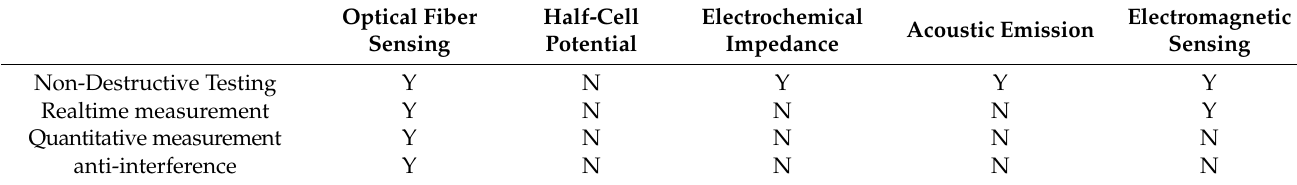
Table 1. Comparison with traditional corrosion monitoring